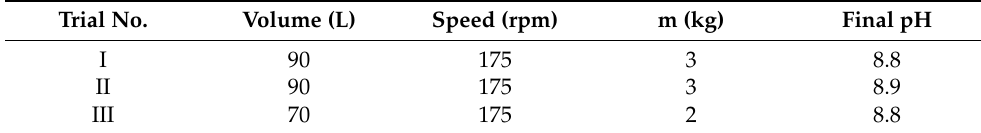
Table 5. Stepwise dosing trials liters, rpm, total mass of added slag, and final pH obtained. Trial